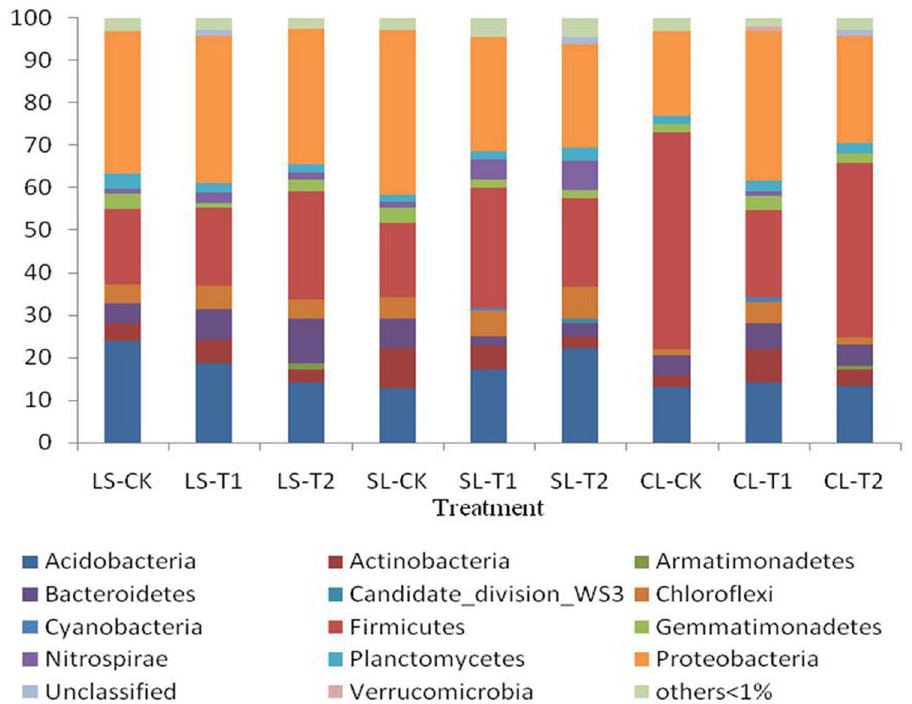
Figure 4. Relative abundance of the bacterial predominant phyla for different samples. LS loam soil, SL sandy loam, CL clay loam, CK no fertiliser, T1 conventional fertilisation, T2 no nitrogen